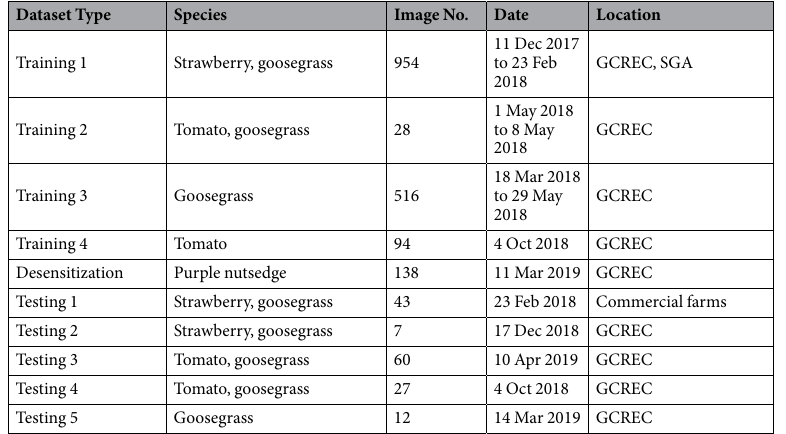
Table 4. Training, desensitization, and testing dataset specifications for developing a convolutional neural network to detect goosegrass ( Eleusine indica ) in Florida strawberry ( Fragaria × ananassa ) and tomato ( Solanum lycopersicum ) production. Abbreviations: GCREC = Gulf Coast Research and Education Center at Balm, FL; SGA = Strawberry Growers Association field site in Dover,